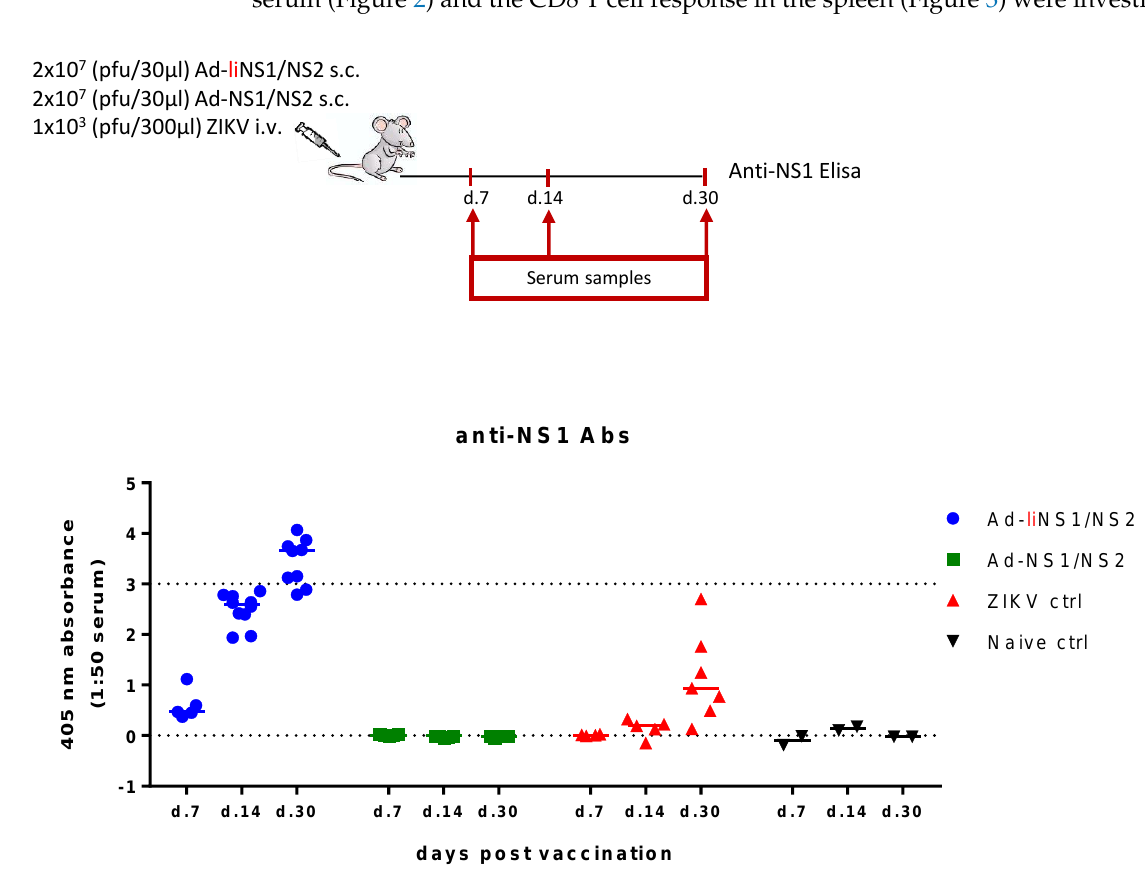
Figure 2. Anti-NS1 antibody levels induced by the Ad-liNS1/NS2 and Ad-NS1/NS2 vaccines. WT C57BL/6 mice were vaccinated s.c. with 2 × 10 7 pfu of either vaccine (Ad-liNS1/NS2 and Ad-NS1/NS2). ZIKV-immune and naive mice were included for control. On days 7, 14, and 30 post vaccination, serum samples were collected and the levels of NS1-antibodies were measured based on an ELISA kit. Each dot represents an individual animal. The vertical bars represent the group medians and the stippled lines the assay